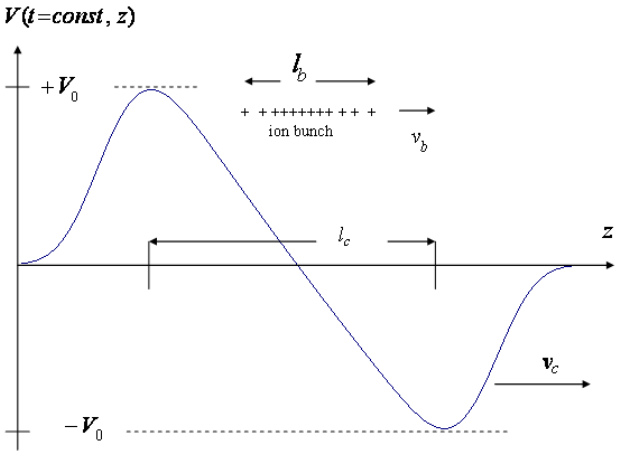
FIG. 3. (Color) Snapshot of voltage on helix vs z